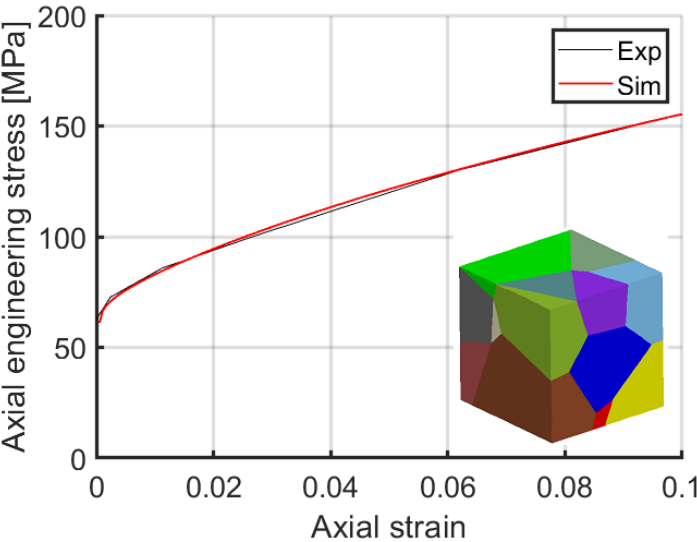
Figure 1. Stress–strain curves of experiments and